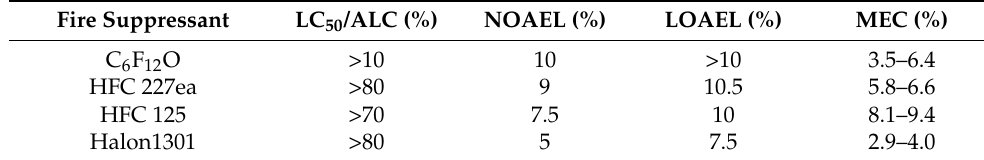
Table 3. Toxic data and minimum extinguishing concentration of typical gas fire suppressants [2,14]. Fire